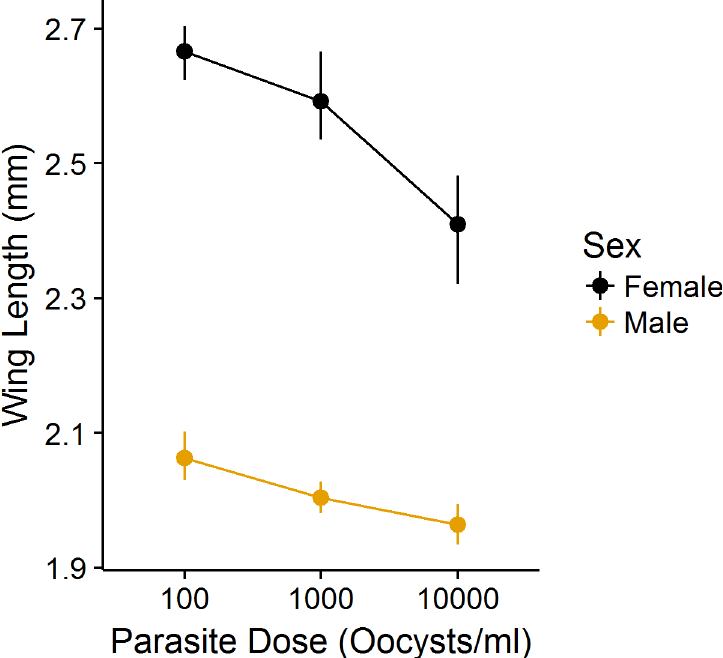
Fig 2. The mean wing length of female and male mosquitoes exposed to different parasite dosages. Both female and male mosquitoesshow smaller body size when parasitized,but the relative effect for female Ae . albopictus appearsgreater, as evidencedby the interactionbetweensex and dosage (Table 2). Whiskers are bootstrapped 95% confidenceintervals(1000 replicates); no confidence intervals for any points overlap.